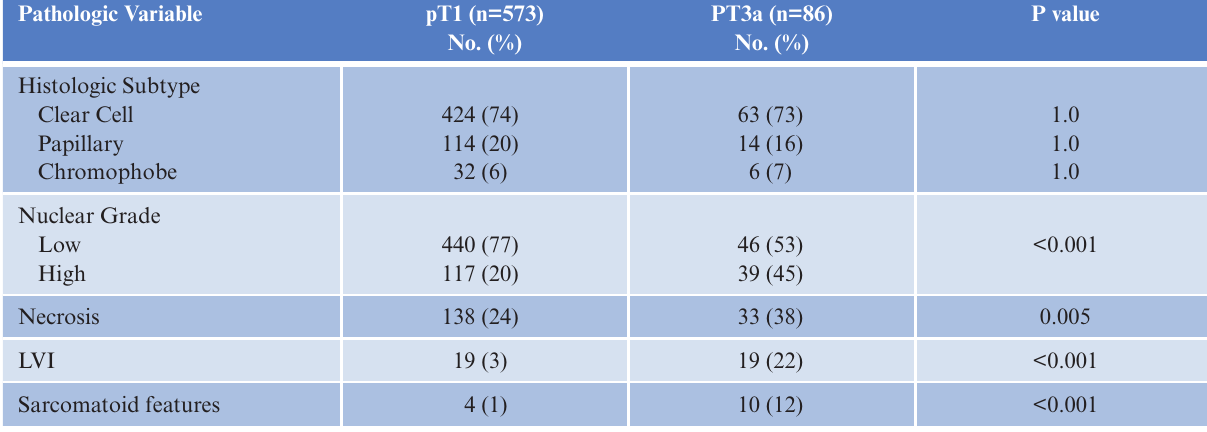
Table 3: Pathologic characteristics of 659 RCC tumors < 7cm in size stratified by stage (pT1 vs. pT3a) Pathologic